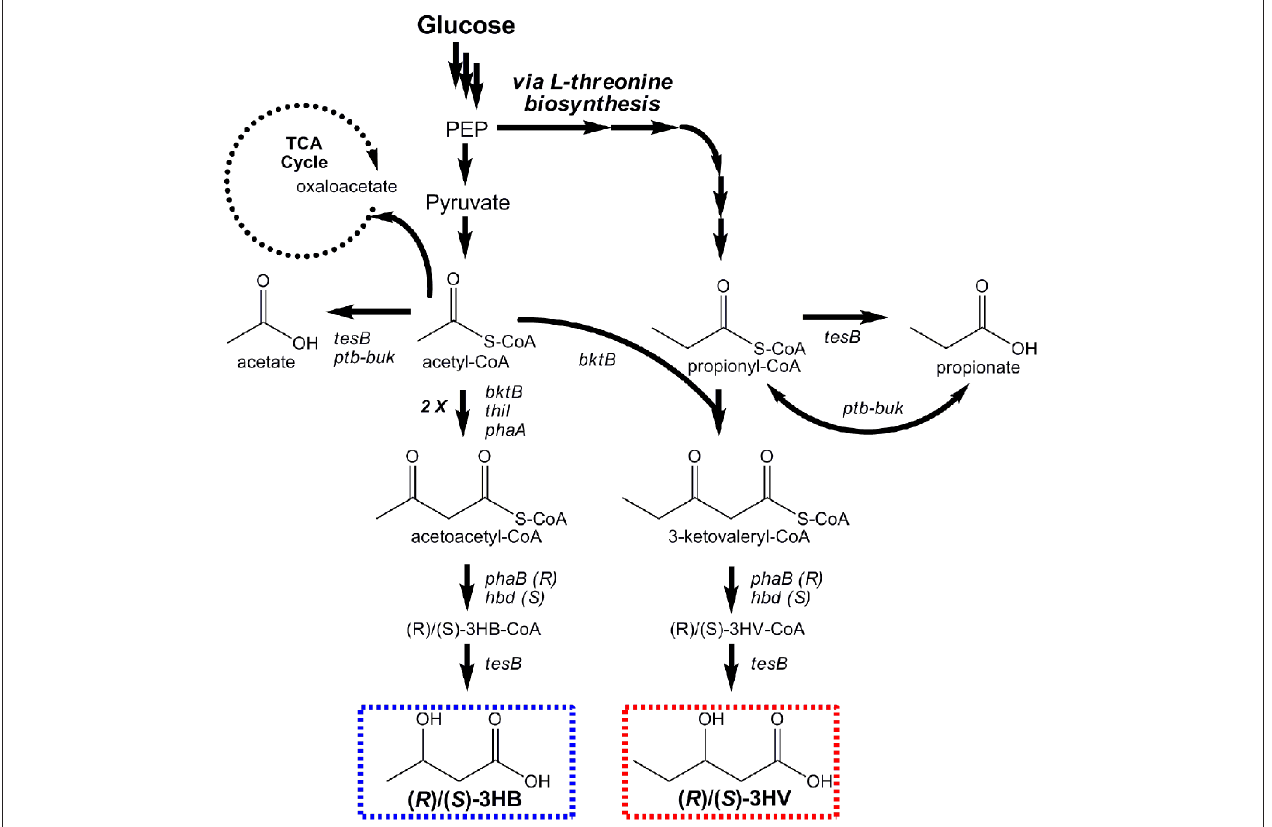
FIGURE 6 | Pathways engineered for stereoselective production of (R) - and (S) -3-hydroxybutyrate and (R) - and (S) -3-hydroxyvaleratefrom